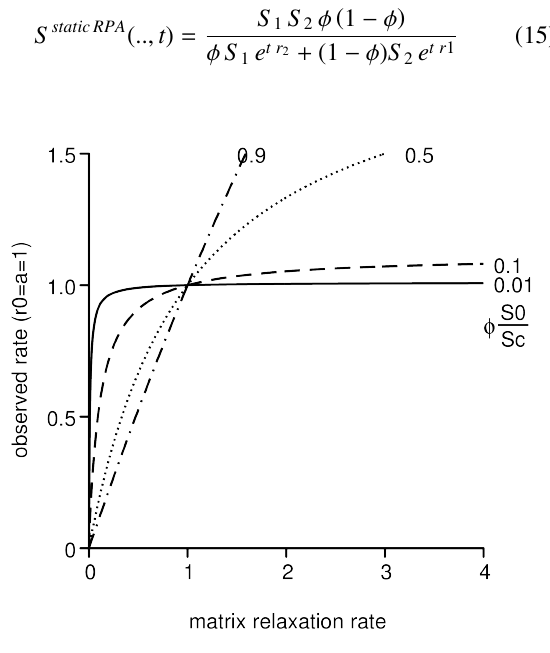
Figure 3. Resulting exponential decay rate for a hypotheti- cal mixture of chains with di ff erent simple exponential relax- ations. The example shows the dependence of the observed rate r RPA as function of a matrix relaxation rate r matrix = r c = r 2 for fixed r 0 = r 1 = 1 di ff erent curves pertain to di ff erent ratios ϕ S 0 ( Q / [(1 − ϕ ) S c ( Q